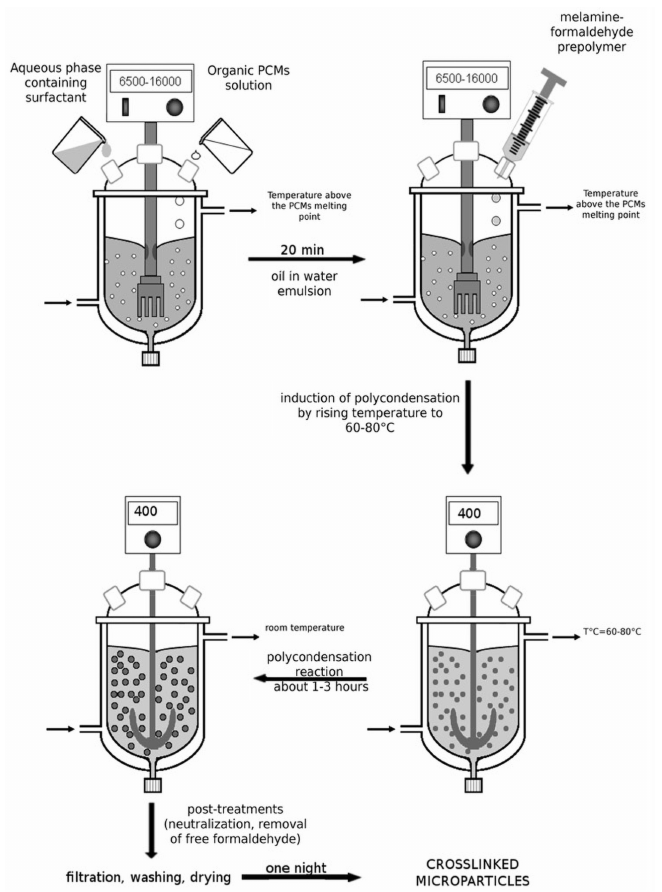
Figure 6. Schematic representation of the microencapsulation process by in situ polymerization